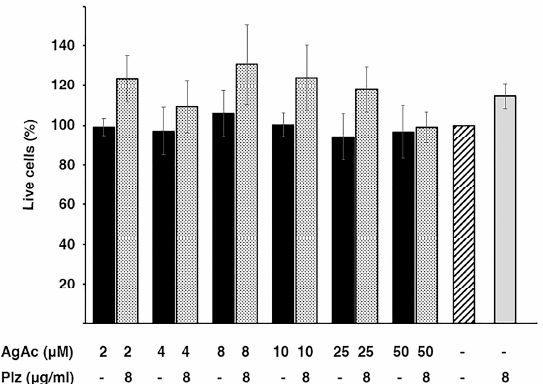
Figure 4. Cytotoxicity of silver acetate and plazomacin. Cytotoxicity on HEK293 cells was assayed using a LIVE/DEAD kit as described in the Materials and Methods section. The percentage of surviving cells was calculated relative to cells untreated (striped bar). Control of maximum toxicity was determined by incubating the cells in 70% methanol. Assays were carried out in triplicate and the values are mean ± SD of three independent experiments.